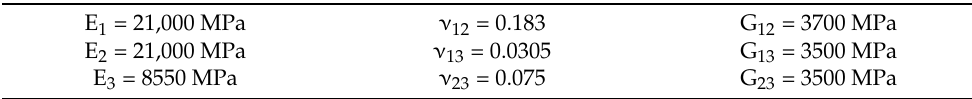
Table 1. Glass fibre reinforced polymer (GFRP) laminate properties.